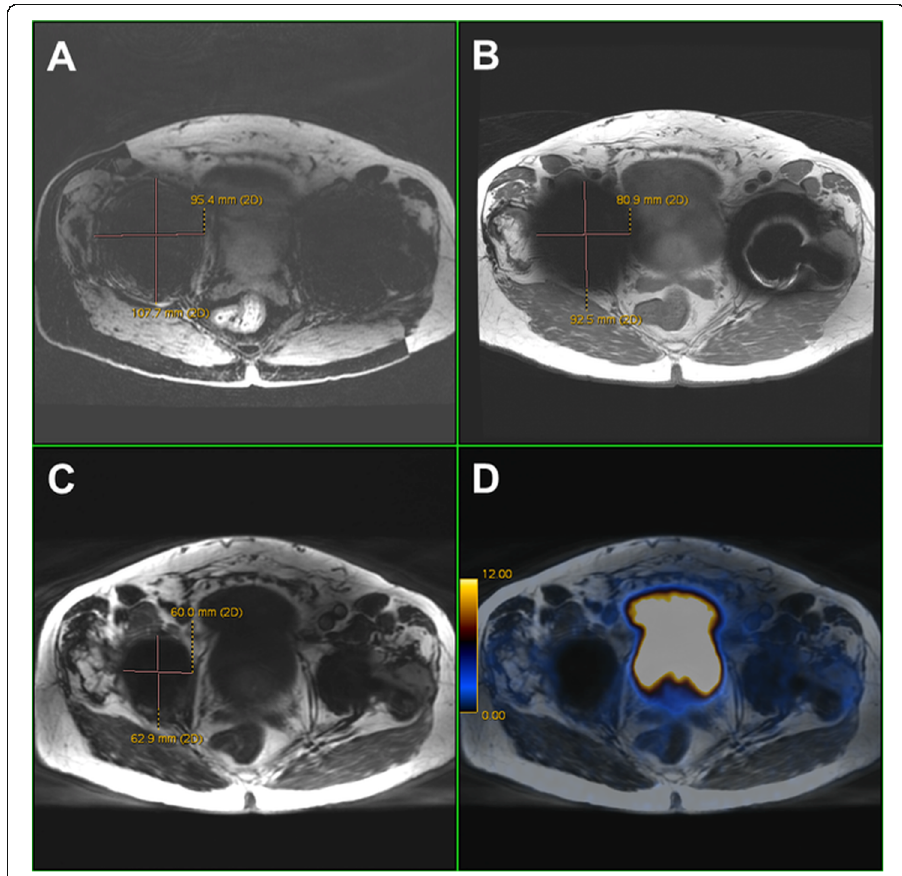
Fig. 1 Different appearances of MR signal voids due to hip joint implants. Axial images of a patient with bilateral hip joint implants, referred to 68 Ga-PSMA-11 PET/MRI for staging prostate cancer. a LAVA-FLEX. b T1w-FSE. c MAVRIC-SL show the different size of signal voids, with the corresponding fused image. d PET/MRI MAVRIC-SL